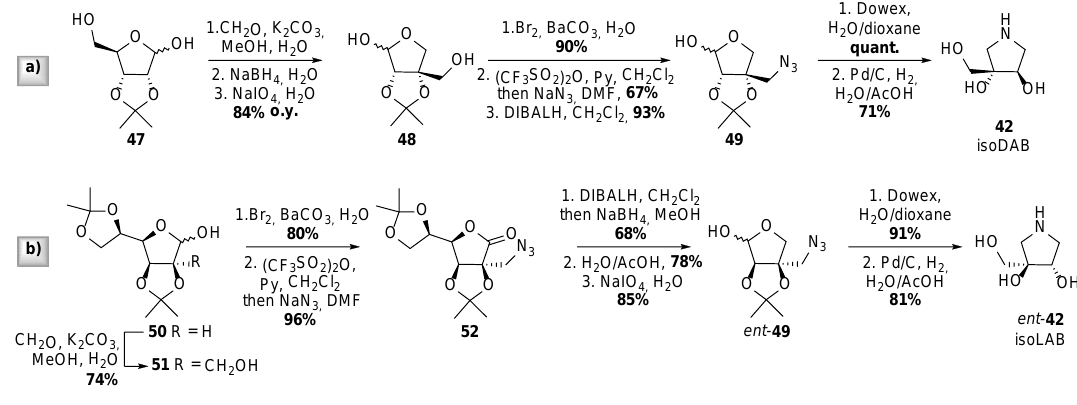
Scheme 6. Synthesis of ( A ) isoDAB and ( B ) isoLAB[136].